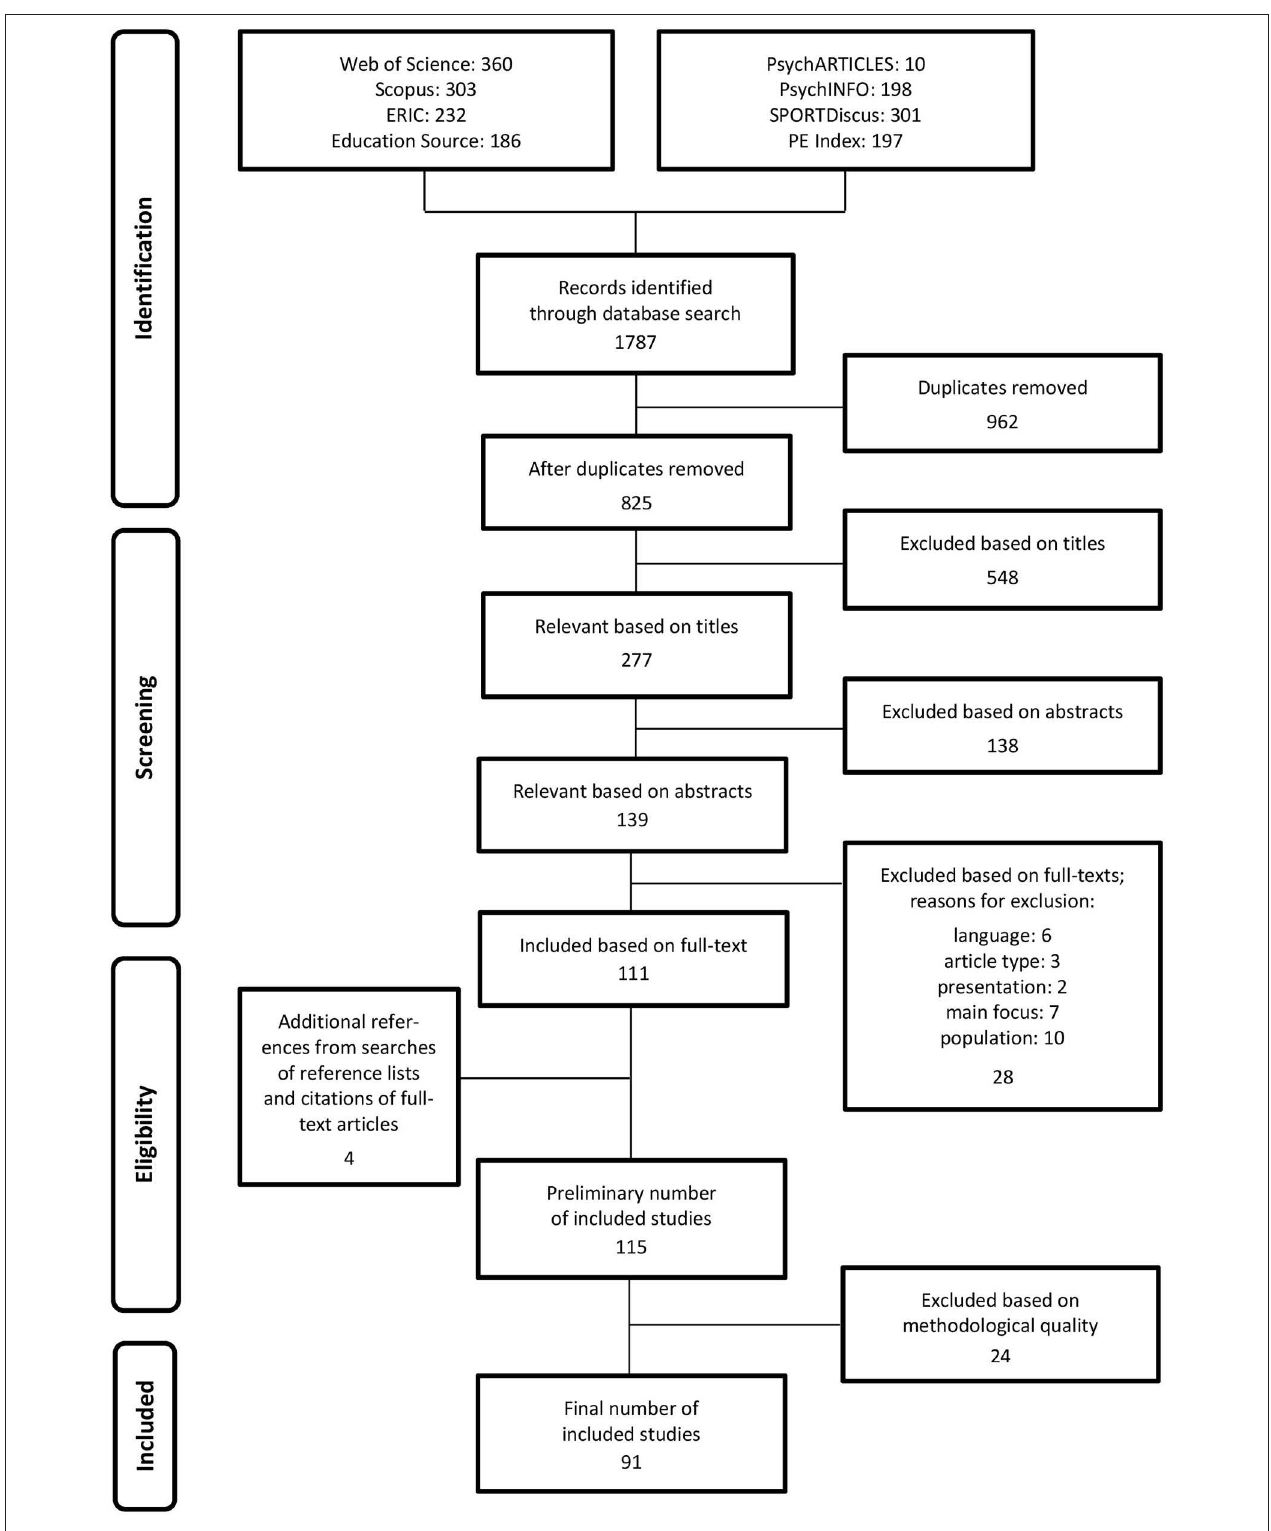
FIGURE 2 | Flow chart of study search and selection